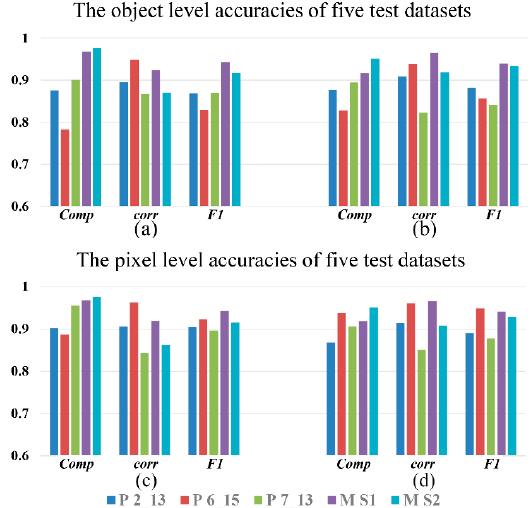
Figure 9. The three metrics of the five test scenes at the object level and the pixel level. ( a ) The object level accuracies of the method CNN_ACM_1, ( b ) the object level accuracies of the method CNN_ACM_2, ( c ) The pixel level accuracies of the method CNN_ACM_1, and ( d ) the pixel level accuracies of the method CNN_ACM_2. The abbreviations of P, M and T are the same as Figure 8.